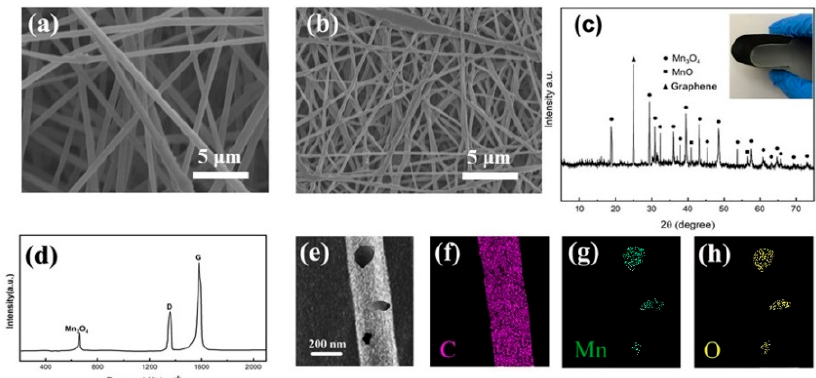
Figure 2. SEM images of the electrospun fibers before ( a ) and after ( b ) heat treatment. ( c ) XRD patterns of the nanofibers on cathodes. ( d ) Raman spectra of Mn 3 O 4 / CNFs. ( e – h ) Element mappings of Mn 3 O 4 /